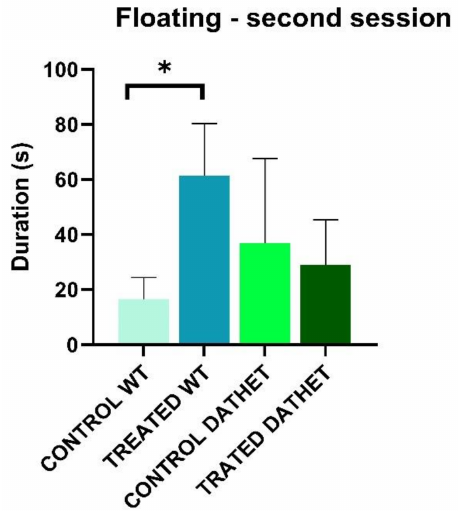
Figure 3. Forced swimming test was performed twice, in the morning and in the afternoon. The bar graph shows duration of floating (0–150 s of afternoon session) for WT and DATHET control rats and WT and DATHET rats treated with Moringa . Duration was higher in WT-treated subjects than water control subjects. Error bars represents standard errors of mean, SEM. Post-Hoc HSD Tukey: * p < 0.05 compared to control rats.